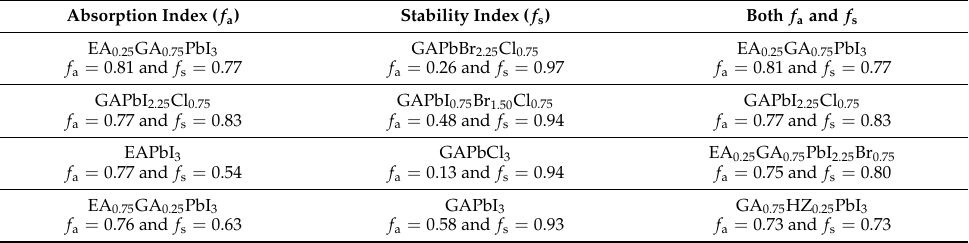
Table 2. Selection of 10 best candidates with the goal of optimizing: (a) absorption index f a ; (b) stability index f s ; both f a and f s , with values larger than 0.65. The intrinsic degradation mechanism has been